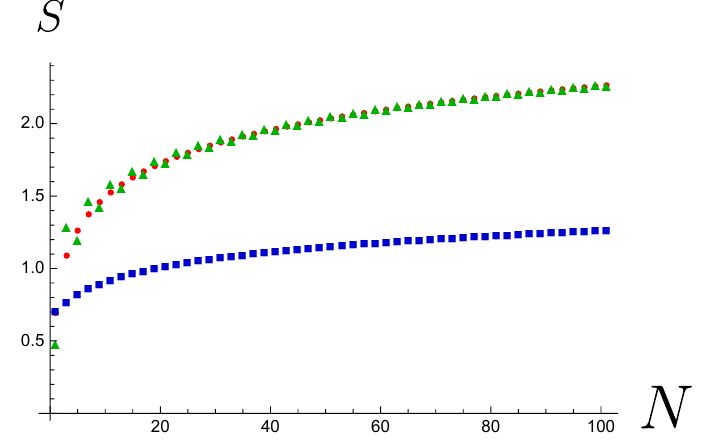
Figure 4 . Entanglement entropy for a half region. The blue square and green triangular markers are the entanglement entropies for the left half subregion A = ( − L/ 2 , 0) and the middle half subregion A = ( − L/ 4 , L/ 4) , respectively, in the Dirichlet boundary condition. The red round markers are for the half region in the circle (the periodic condition). The green triangular markers are almost the same as the red round ones for large N